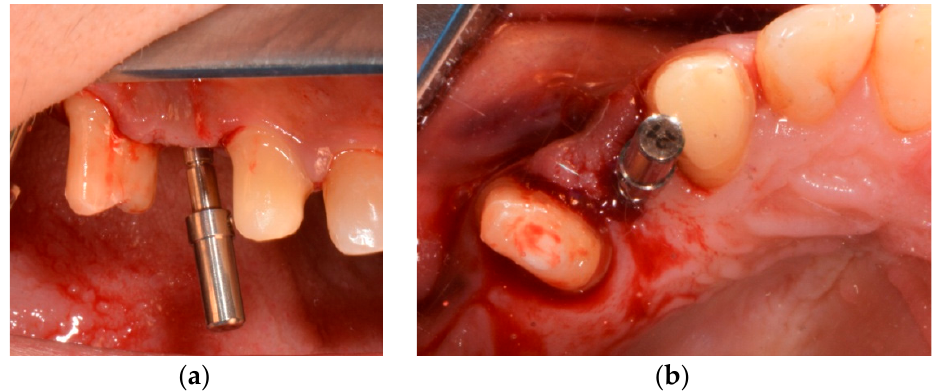
Figure 7. ( a ) Control of the position with the implant direction indicator; ( b ) control of the position with the implant direction indicator.